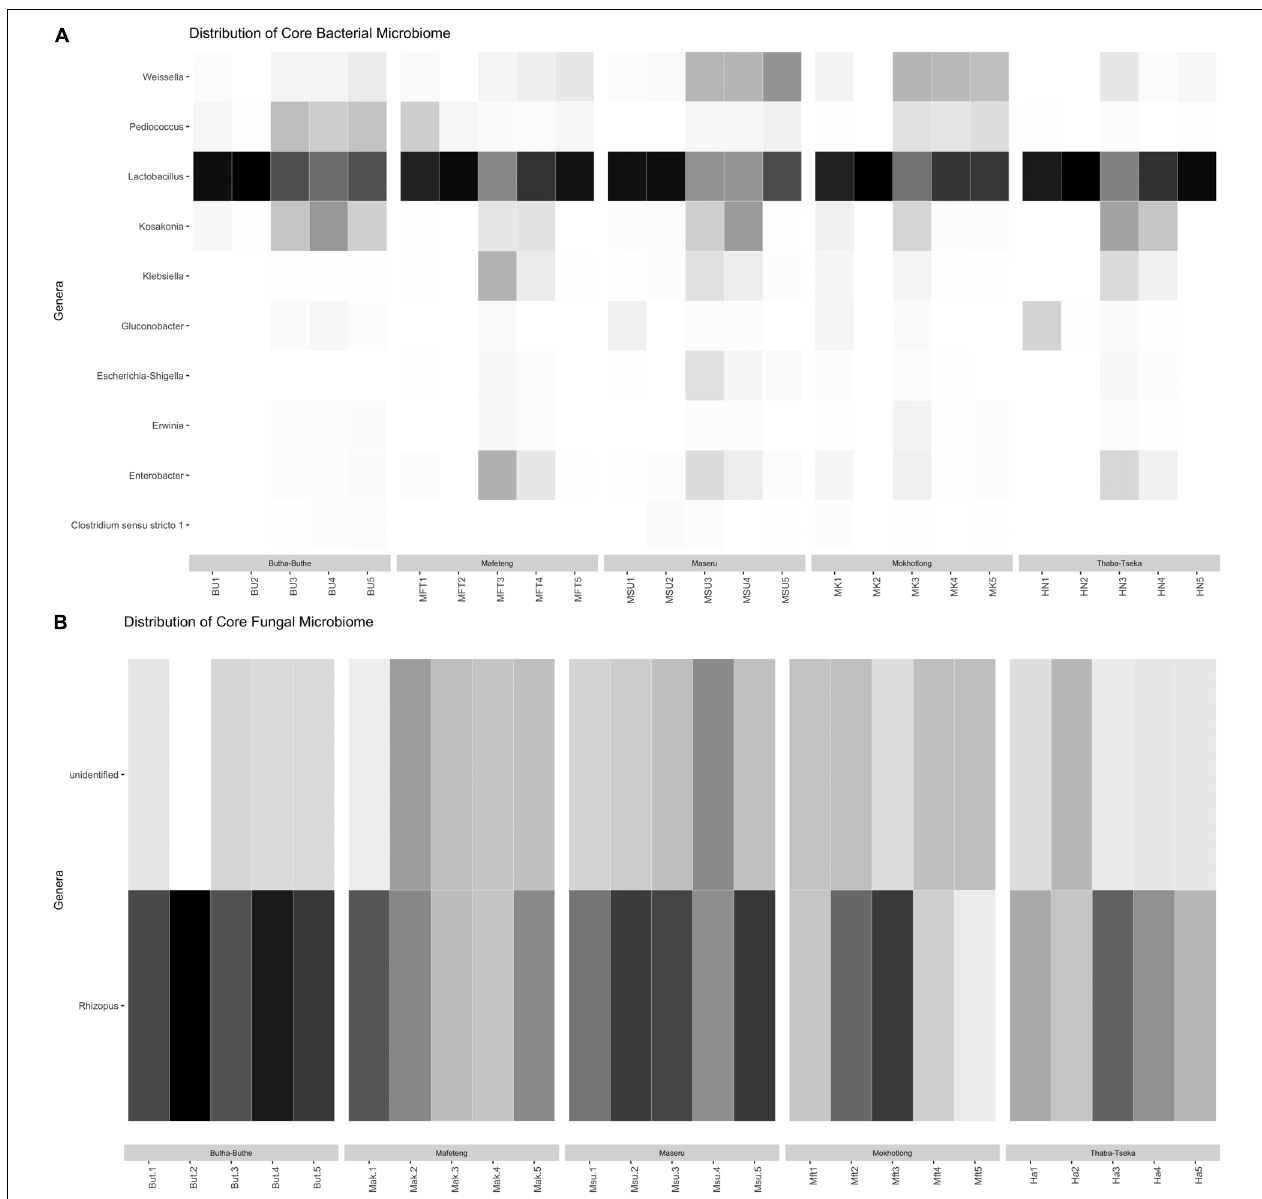
FIGURE 3 | Heatmap of genera within the (A) bacterial and (B) fungal core microbiomes.